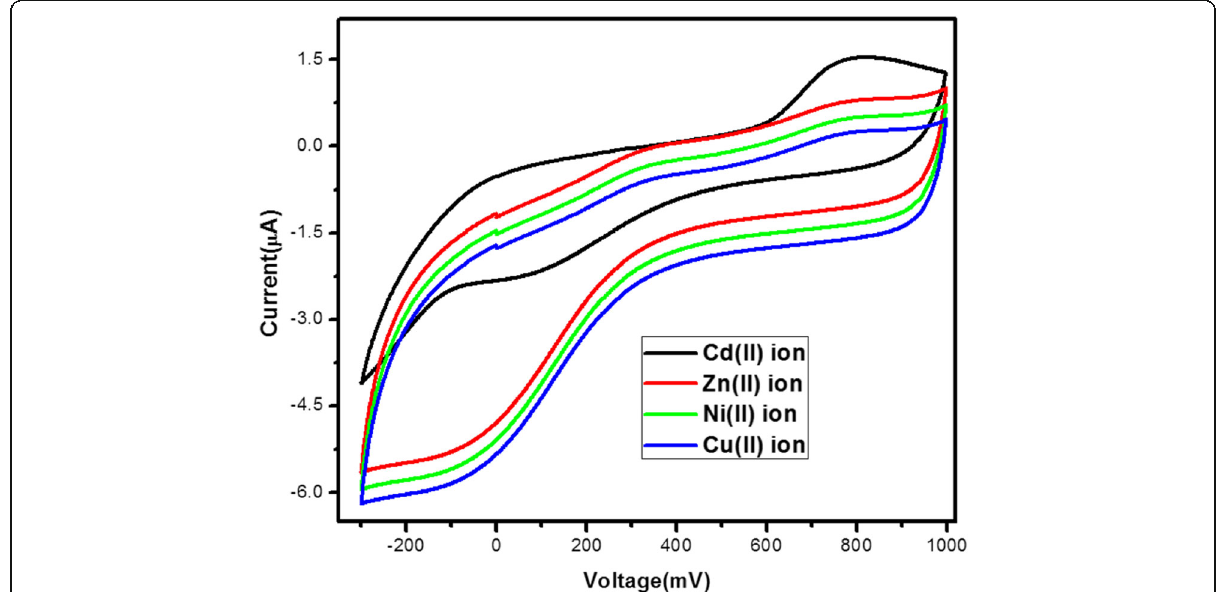
Fig. 11 Selectivity studies of Pt-MWCNT-IIP towards various metal